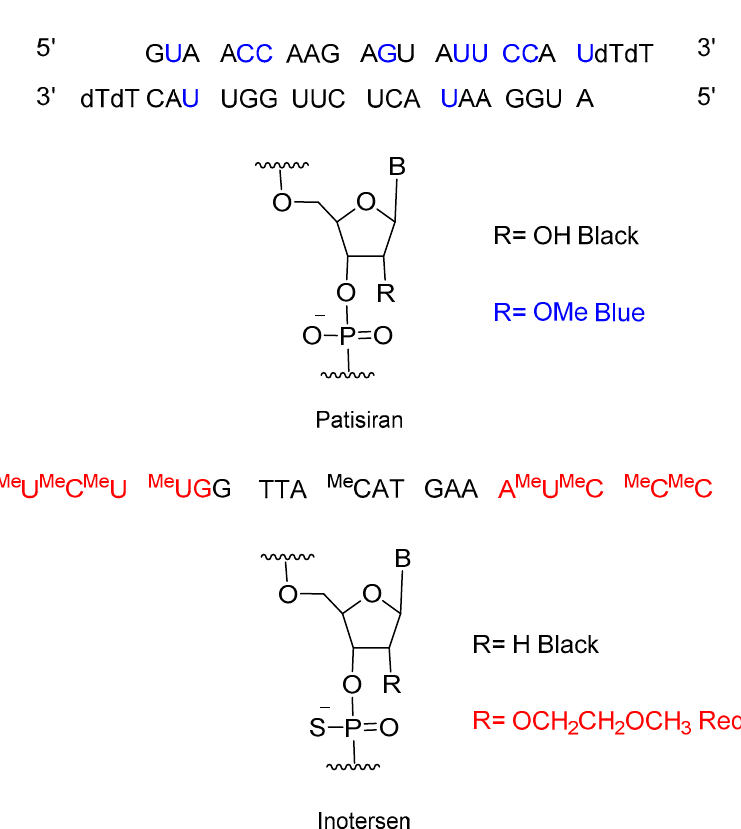
Figure 2. Structure of oligonucleotide based drugs, patisiran and inotersen.